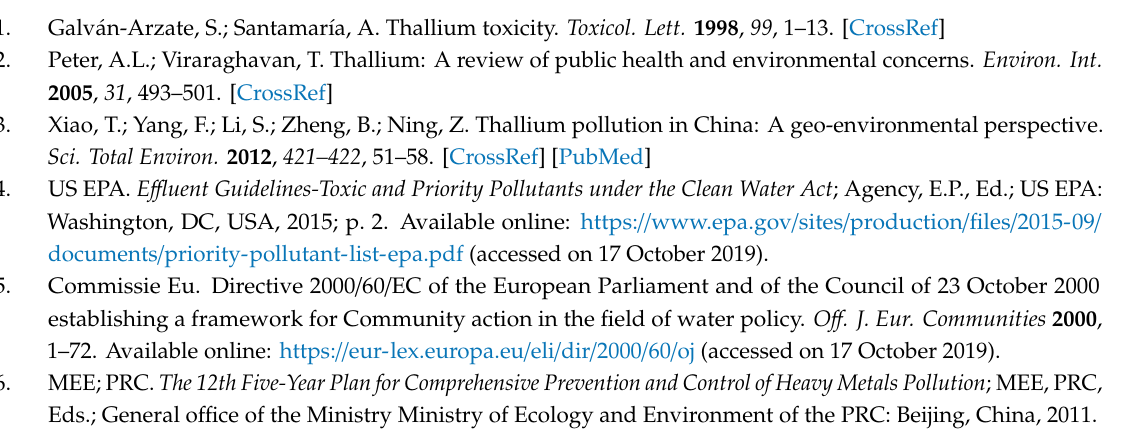
Figure S1: E ff ect of electrode material on Tl(I) removal e ffi ciency within 20 min EC treatment under applied current density of 16.7 mA / cm 2 with initial pH of 11 ± 0.1, electrodes distance of 2 cm, C 0 = 109 µ g / L. Figure S2: E ff ect of pH on Mg removal e ffi ciency within 20 min EC treatment under applied current density of 16.7 mA / cm 2 , using Fe-Fe electrodes at distance of 2 cm, C 0 = 41.5 mg / L. Figure S3: E ff ect of pH on Tl(I) removal e ffi ciency of the as-prepared FeOOH. Adsorbent dose 0.44 g / L, agitation speed at 100 rpm for 4 hours at room temperature (25 ◦ C), C 0 = 141 µ g / L. Figure S4: E ff ect of Cl − concentration on Tl(I) removal e ffi ciency within 20 min EC treatment under applied current density of 16.7 mA / cm 2 , initial pH of 11 ± 0.1, using Fe-Fe electrodes at distance of 2 cm, C 0 = 95 µ g / L. Figure S5: E ff ect of initial Tl(I) concentration on Tl(I) removal e ffi ciency within 20 min EC treatment under initial pH of 11 ± 0.1 with aeration of 0.2 L / min, using Fe-Fe electrodes at distance of 2 cm, C 0 = 66, 115, 141, 165 µ g / L, respectively. Figure S6: Removal e ffi ciency of high Tl(I) concentration within 60 min EC treatment under initial pH of 11 ± 0.1 with aeration of 0.2 L / min, using Fe-Fe electrodes at distance of 2 cm, C 0 = 660, 10,000 and 17,300 µ g / L, respectively. Figure S7: E ff ect of pH on Tl(I) removal e ffi ciency of e ffl uent after 20 min EC treatment under applied current density of 16.7 mA / cm 2 with aeration of 0.2 L / min. using Fe-Fe electrodes at distance of 2 cm. Initial pH of 7 and 11, respectively. Table S1: The content of Fe 3 + and TFe (wt.%) in flocculent sludges obtained at vary initial pH. Table S2: The specific surface area, average pore size and pore volume of flocculent sludges obtained at vary initial